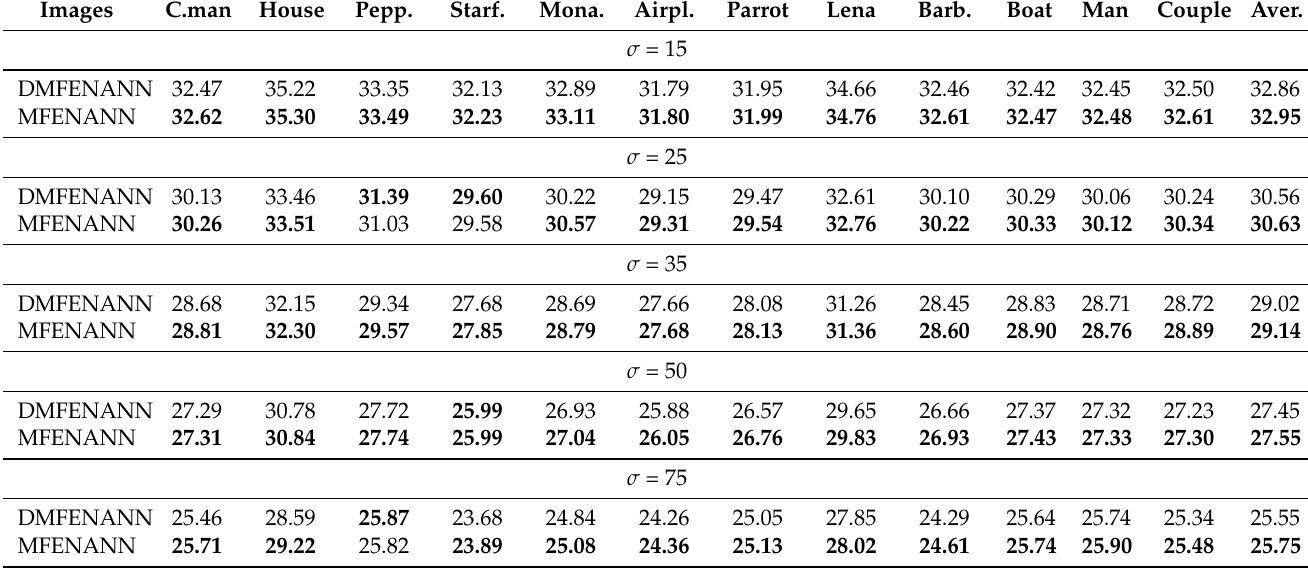
Table 2. The PSNR (dB) values for restored images from “Set12” using DenseMFENANN (DMFENANN) and MFENANN at noise levels of 15, 25, 35, 50 and 75. The bold numbers are the largest from the corresponding noise levels. Images